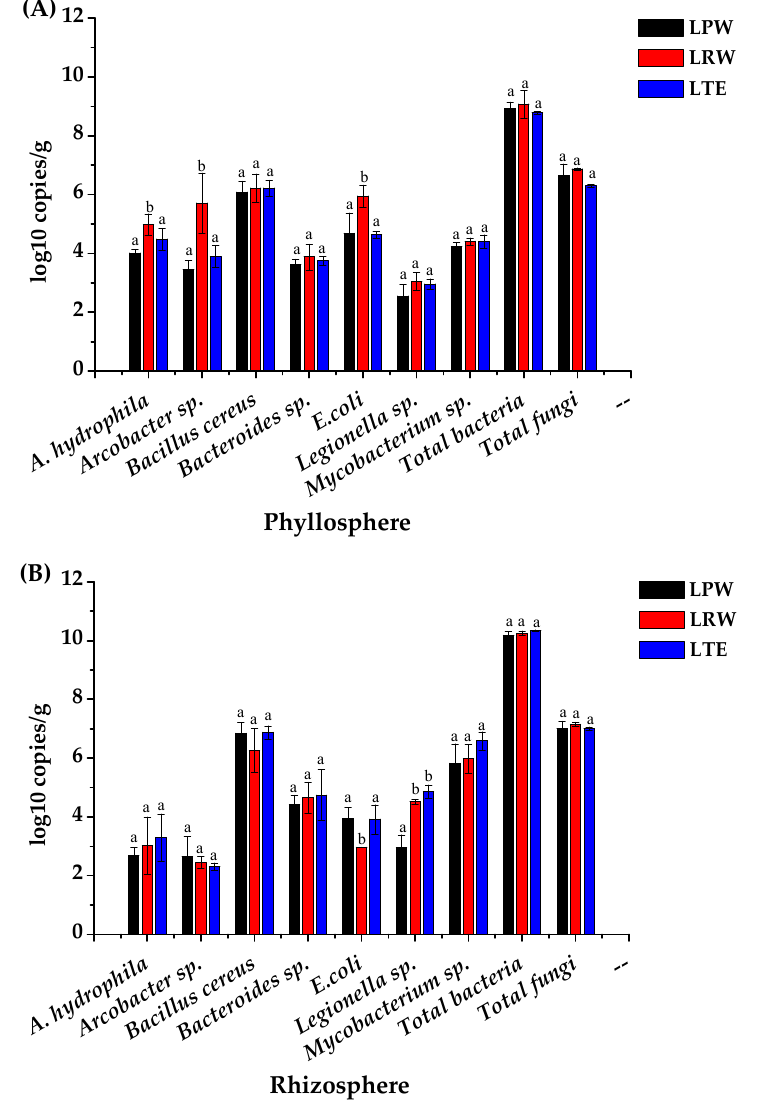
Figure 3. Pathogenic bacteria in the phyllosphere ( A ) and rhizosphere ( B ) of lettuce irrigated with potable water and wastewater for two months irrigation (error bars indicate standard deviation from average, n = 3). Mean values ( n = 3) in each group followed by the same lowercase letter are not significantly different using Tukey’s HSD test at p < 0.05.